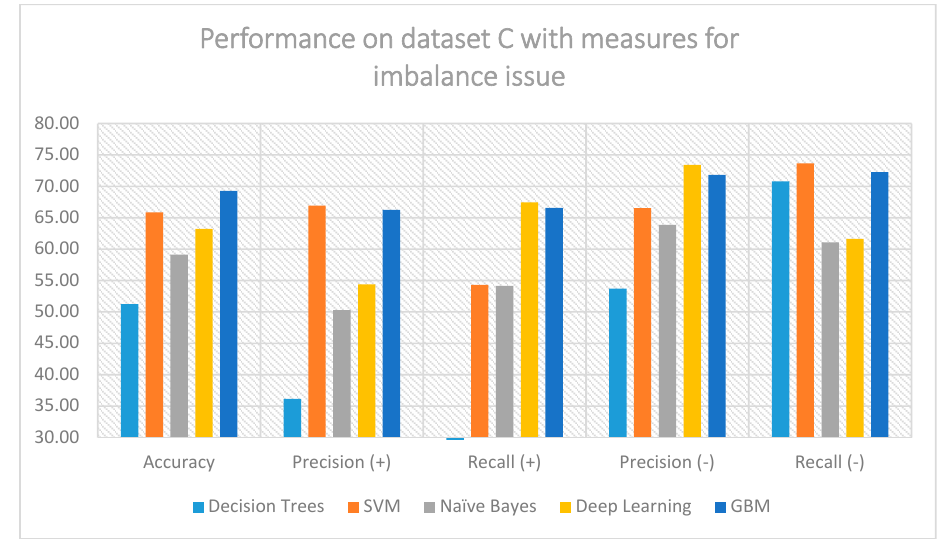
Figure 4. Evaluation scores of all classifiers against the positive imbalanced set upon taking measures for the class imbalance problem.